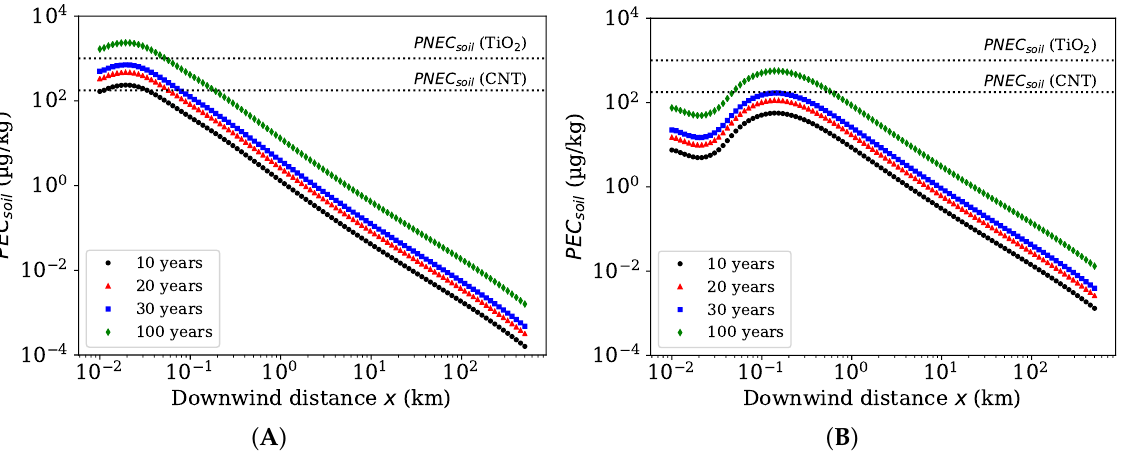
Figure 4. Modeled predicted environmental concentrations of nano-TiO 2 in soil ( PEC soil ) at different distances from the source after 10, 20, 30 and 100 years of continuous emission from ( A ) a spray coating facility Koivisto et al. and ( B ) a paint factory Fonseca et al., see Table 1. The horizontal lines represent predicted no effect concentrations in soil ( PNEC soil ) for nano-TiO 2 and carbon nanotubes